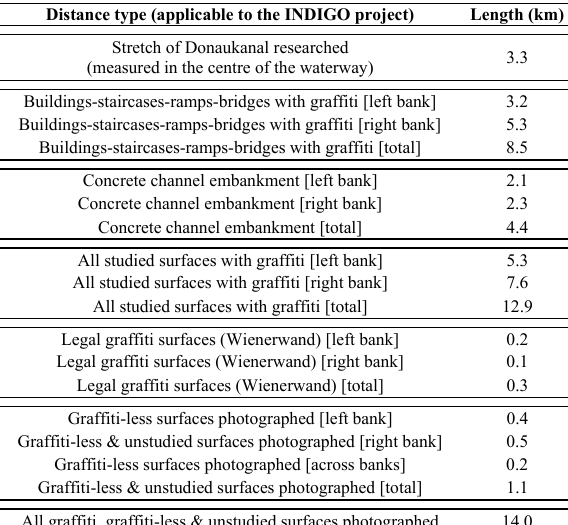
Table 2 . Some INDIGO-relevant distances.